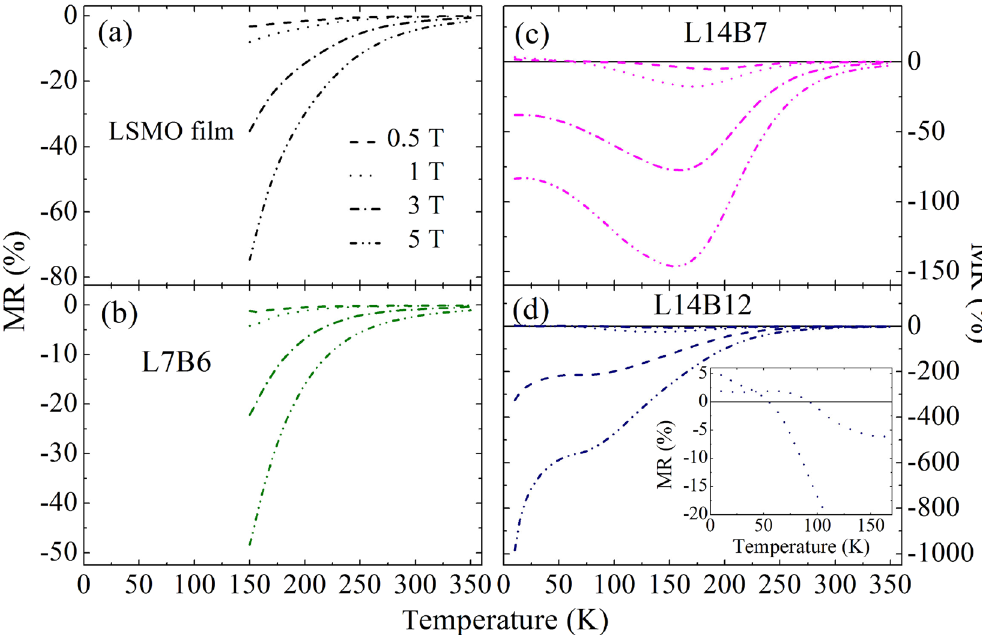
Figure 6. Magnetoresistance, MR = [ ρ (H) −ρ (0)]/ ρ (H) × 100 as a function of temperature for ( a ) the LSMO film, ( b ) L7B6, ( c ) L14B6, and ( d )